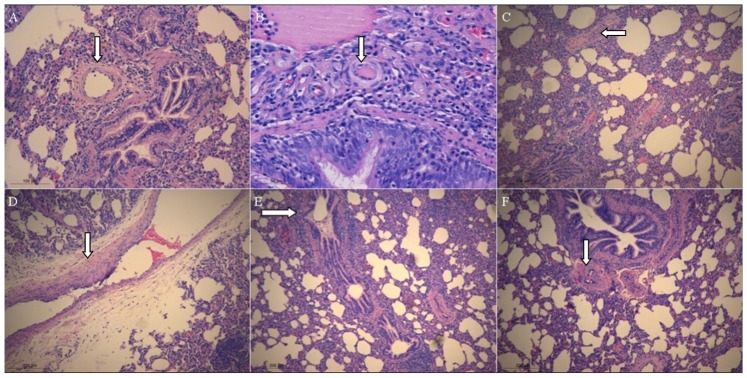
Typical microscopic views of pulmonary hypertension (PH) in a 14-week-old pig at 6 weeks after injection of monocrotaline; Panel A, control group; Panels B-F, MCT group.Panel A: Typical microscopic view of a small muscular pulmonary artery (arrows) in a 14-week-old minipig from the control group. The lumen of normal pulmonary artery is surrounded by a uniform thin wall with no fibrosis or inflammatory cell infiltration (Hematoxylin and Eosin staining; original magnification:×200; scale bar = 100 µm); Panel B: The vessel lumen is narrowed, occluded, twisted or deformed with formation of plexiform lesions (arrows) as a result of proliferating and hypertropic endothelial and smooth muscle cells, intimal fibrosis and accompanying hyalinization (Hematoxylin and Eosin staining; original magnification:×400; scale bar = 50 µm). Panel C: Pulmonary vascular remodeling in the lung tissue. There was intimal thickening accompanied with plexiform lesions (arrows) (Hematoxylin and Eosin staining; original magnification:×100; scale bar = 200 µm). Panel D: Uneven thickening of the pulmonary arterial wall (arrows). (Hematoxylin and Eosin staining; original magnification:×100; scale bar = 200 µm); Panel E: The presence of large amount of mucus (arrows) in bronchioles led to luminal obstruction and lymphocyte infiltration. In the periphery of lungs, congestion of capillaries, thickening of interstitium and focal lymphocyte infiltration were observed (Hematoxylin and Eosin staining; original magnification:×100; scale bar = 200 µm). Panel F: Parabronchus arteries (arrows) were largely occluded owing to extensive neointimal proliferation and medial hypertrophy accompanied with hyalinization (Hematoxylin and Eosin staining; original magnification:×100; scale bar = 200 µm).